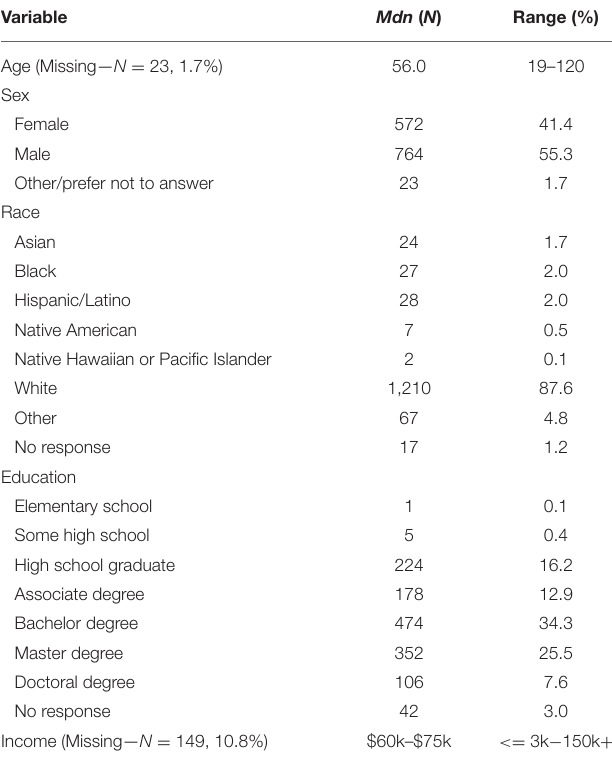
TABLE 1 | Socio-demographic